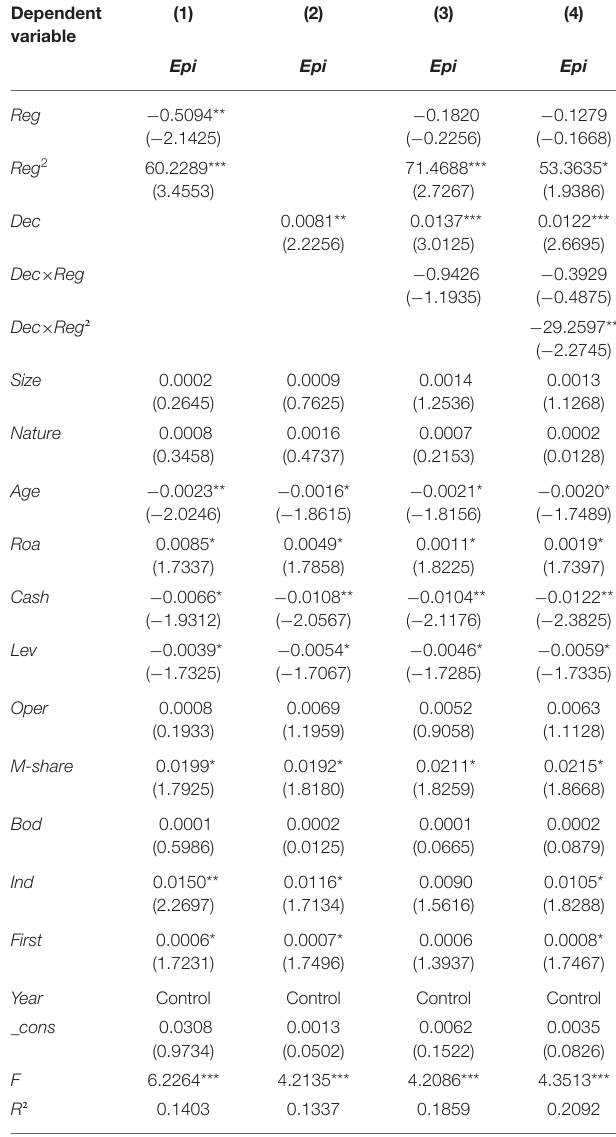
TABLE 4 | Regression